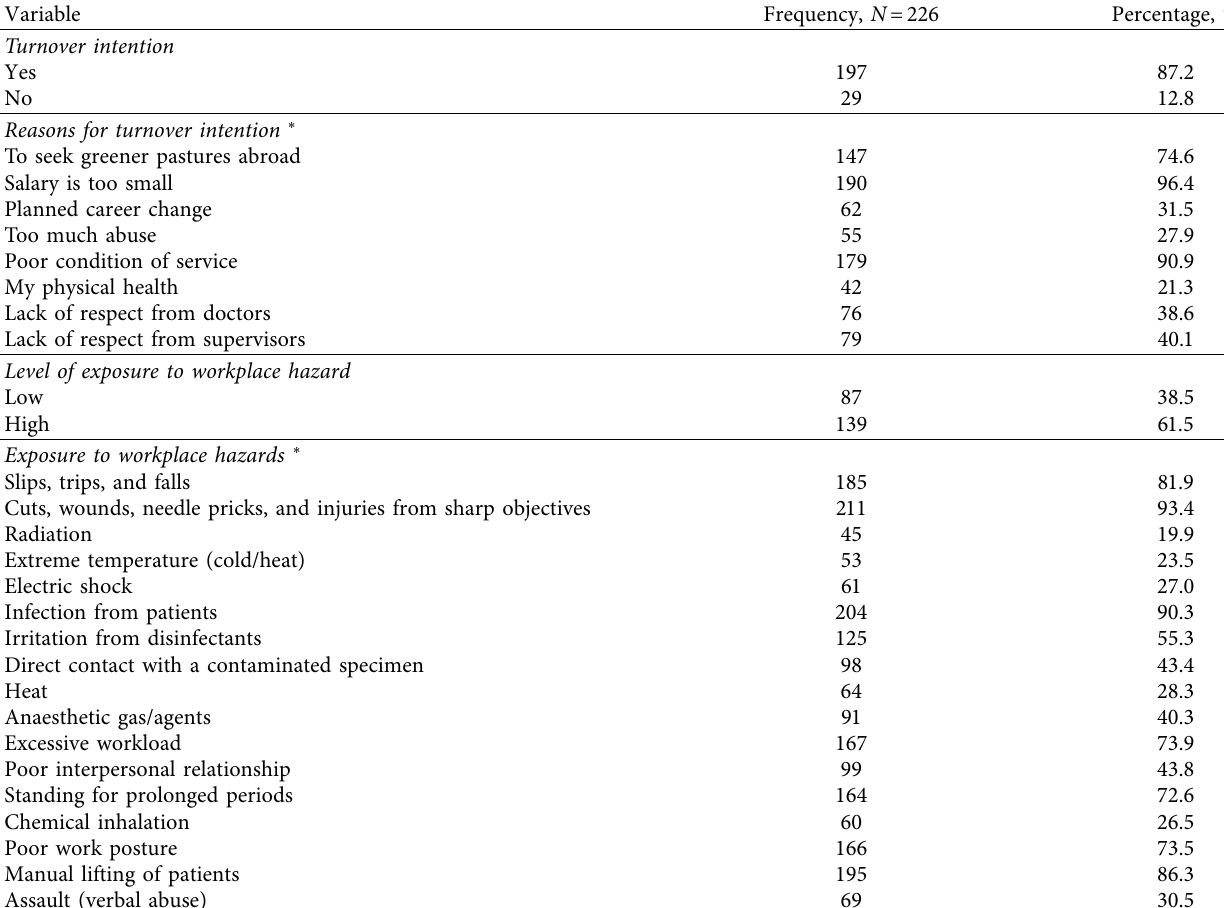
Table 2: Turnover intention and exposure to workplace hazards among study